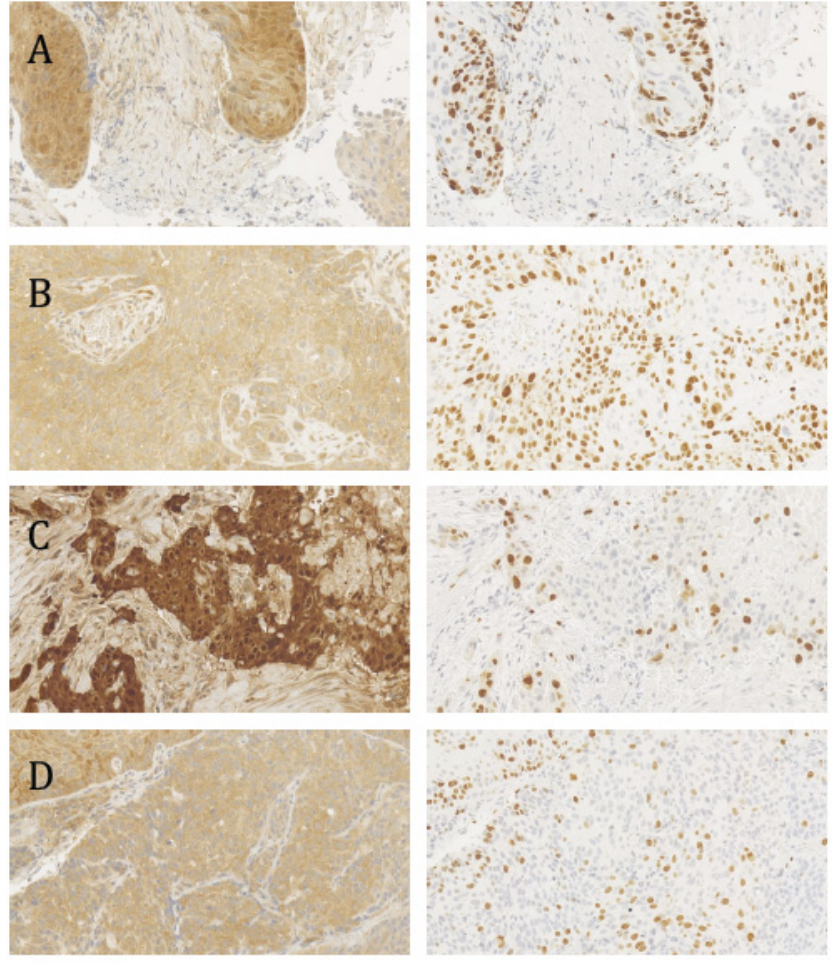
Figure 1. p16 INK4a and Ki-67 staining (left and right panels, respectively) in consecutive sections of human papillomavirus (HPV)-positive and HPV-negative tumor biopsies. ( A ) HPV-positive, diffuse nuclear p16 INK4a staining; ( B ) HPV-positive, diffuse cytoplasmatic p16 INK4a staining; ( C ) HPV-negative, diffuse nuclear p16 INK4a staining. ( D ) HPV-negative, diffuse cytoplasmatic p16 INK4a staining. The proliferation index (Ki-67 staining) is significantly higher in HPV-positive tumors. ( A – D ) were obtained with 20× magnification.